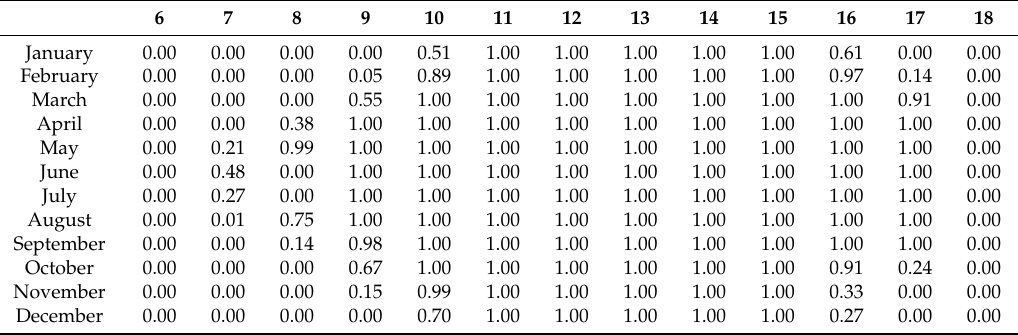
Table 3. Month-by-hour shading matrix generated from the results of shading analysis using SunEye210.